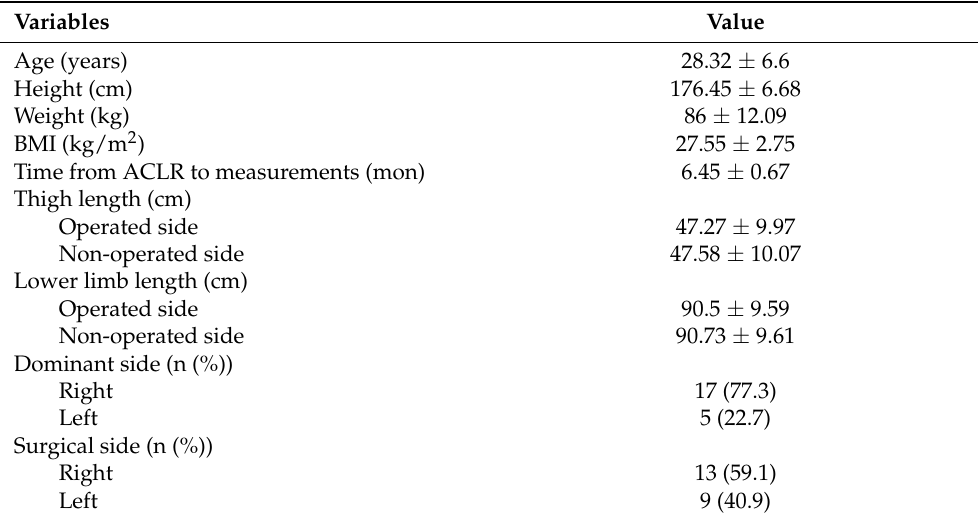
Table 1. Characteristic and clinical variables of the study cohort (n =